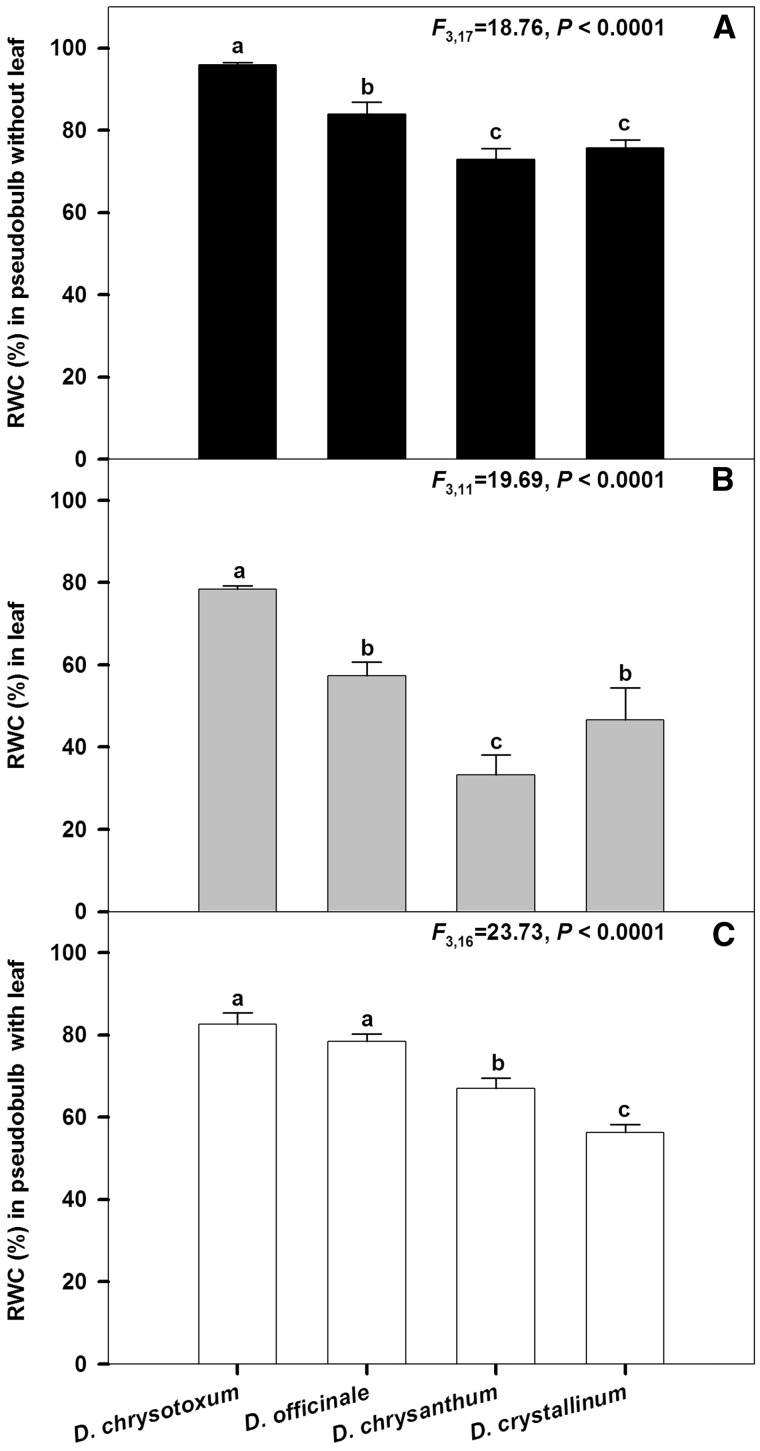
Relative water content (RWC, %) in leafless pseudobulb, excised leaf only and pseudobulb with attached leaves from four Dendrobium species (D. chrysotoxum, D. officinale, D. chrysanthum and D. crystallinum) at 15 days after organs were excised under the same laboratory conditions. Bars are means±SE. For each sample type, significant differences (P<0.0001) among four species are indicated by different letters.